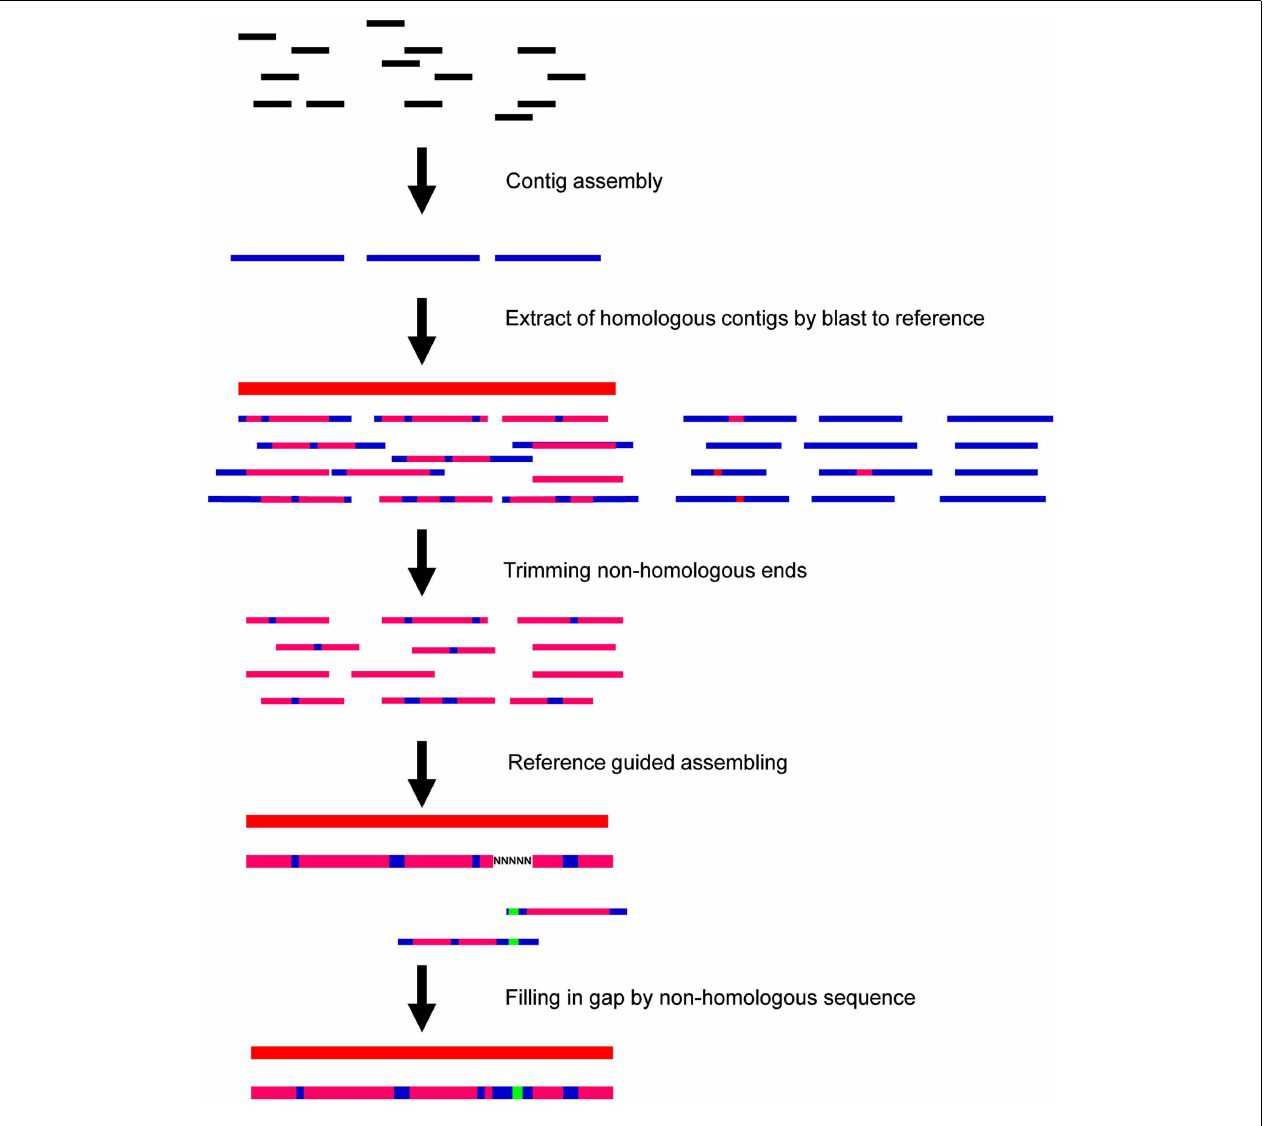
pink bars). Draft consensus (thick pink bar) was constructed guided by reference. Gaps were filled by extending sequence and joining two contigs that overlapped (green bar) by 10 or more